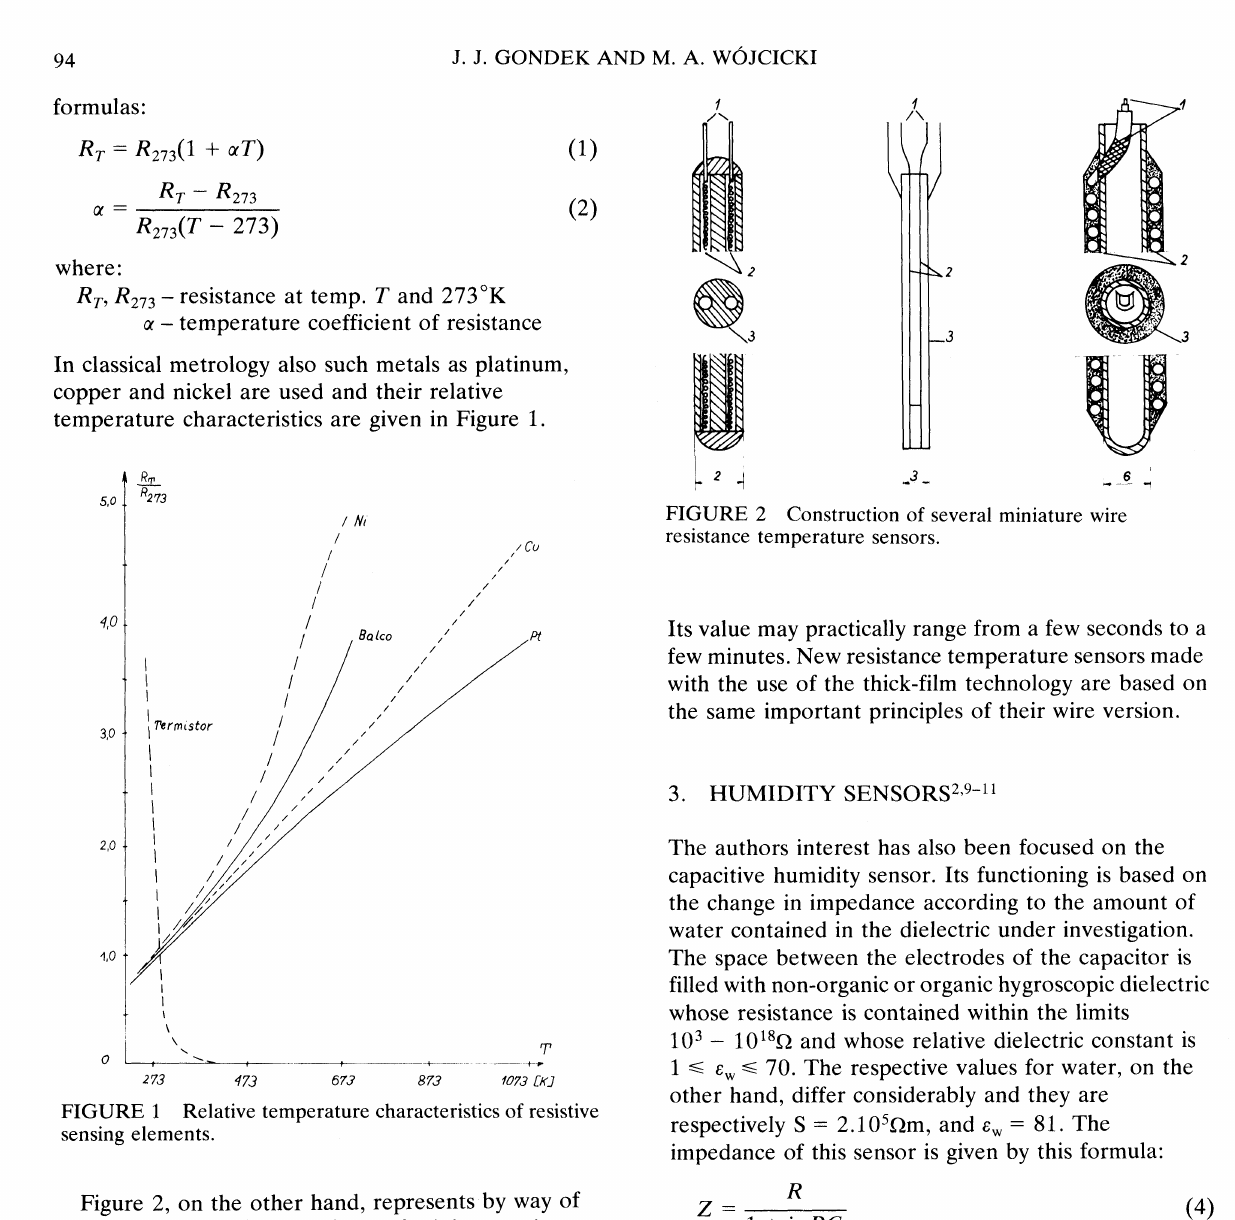
Relative temperature characteristics of resistive sensing elements.